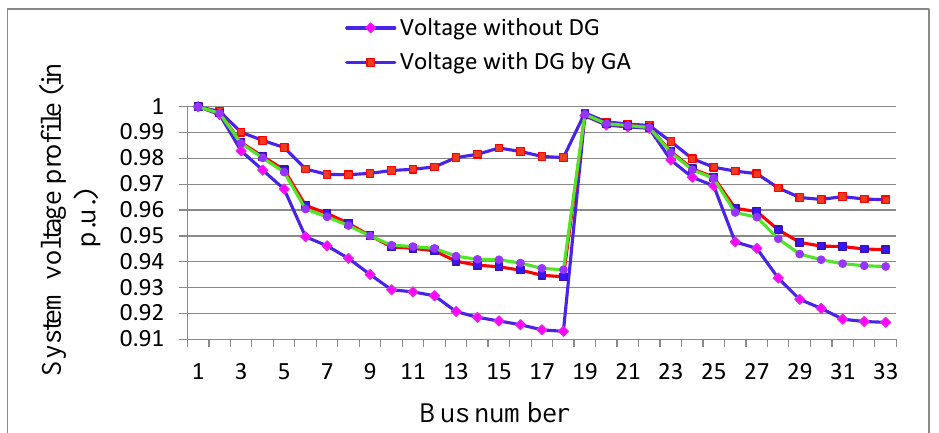
Figure 11. Cost function for GA, PSO, and hybrid-based optimization technique using PEM method for scenario-3.